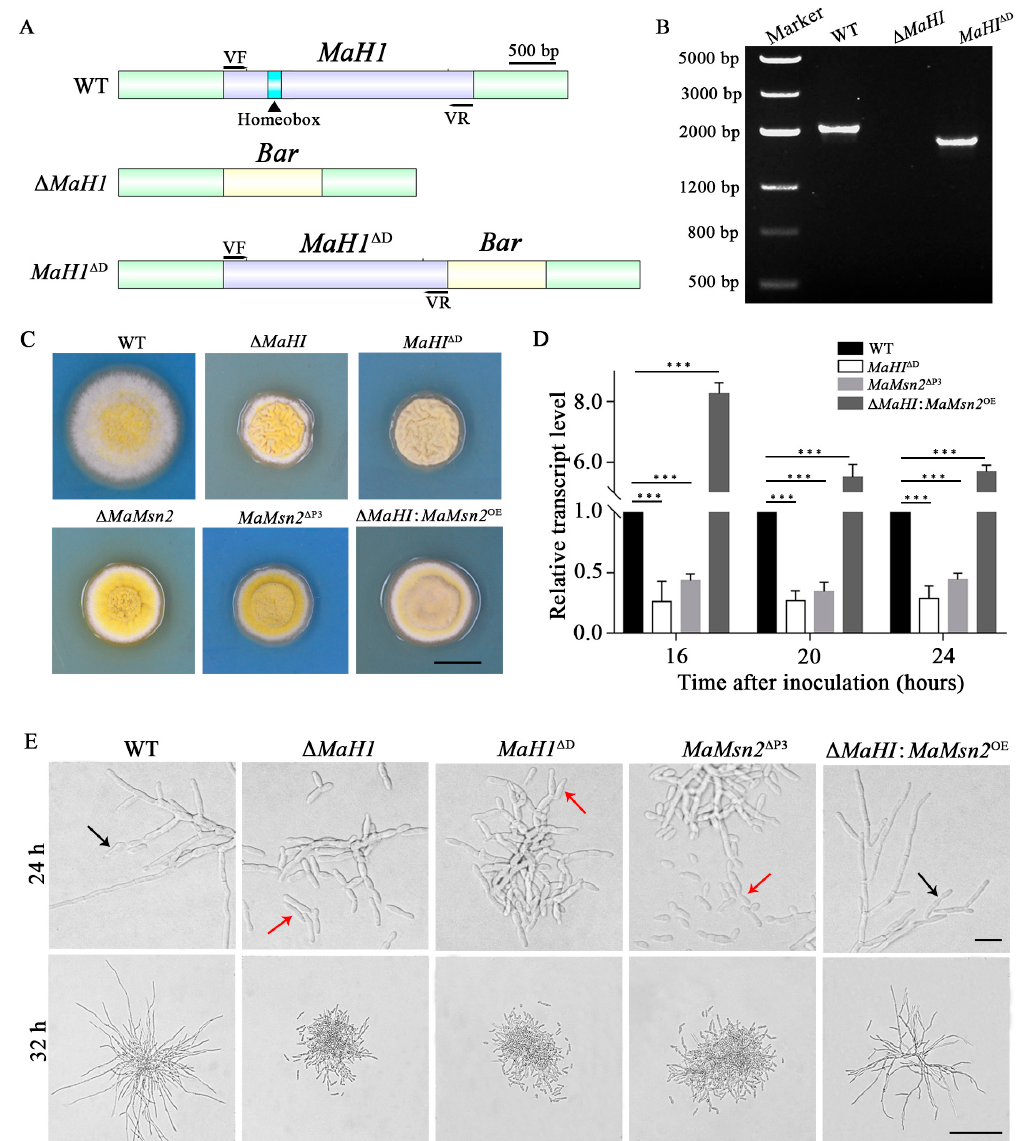
Figure 6. Complementation of Δ MaH1 by MaMsn2 . ( A ) Schematic diagram of deletion of the MaH1 DNA binding domain. ( B ) PCR verification of DNA binding domain knockout strain MaH1 Δ D . Results show a fragment 135 bp smaller in MaH1 Δ D than that of the wild type. ( C ) Colony morphology of Δ MaH1 , DNA binding domain knockout strain of MaH1 ( MaH1 Δ D ), Δ MaMsn2 , promoter P3 region knockout strain of MaMsn2 ( MaMsn2 Δ P3 ) and Δ MaH1 strain overexpressing MaMsn2 ( Δ MaH1 : MaMsn2 OE ). Scale bars indicate 0.5 cm. ( D ) The transcript level of MaMsn2 on 1/4 SDAY medium at 16, 20 and 24 h in MaH1 Δ D , MaMsn2 Δ P3 and Δ MaH1 : MaMsn2 OE strains ( t -test, ***: p < 0.001). ( E ) The conidiation and hyphal development of different strains. Black arrow: normal conidiation; Red arrow: microcycle conidiation. The scale bars indicate 5 μ m at 24 h and 100 μ m at 32 h.